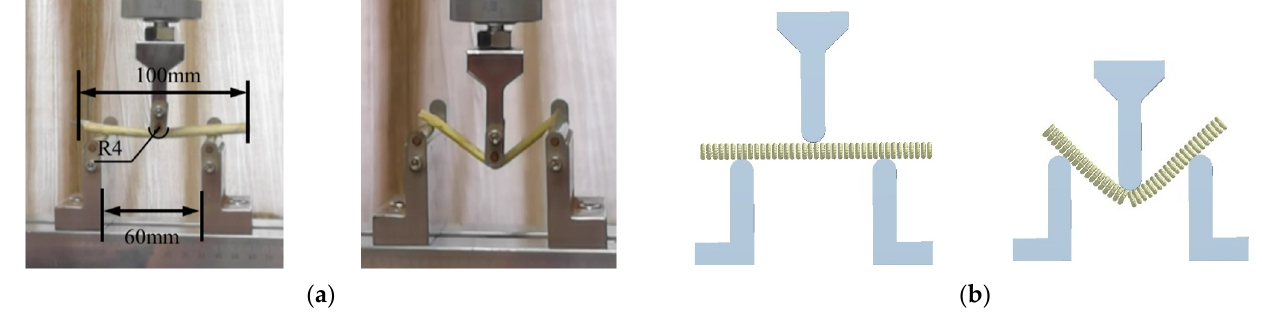
Figure 8. Rape stem three-point bending test: ( a ) Physics test; ( b ) Simulation